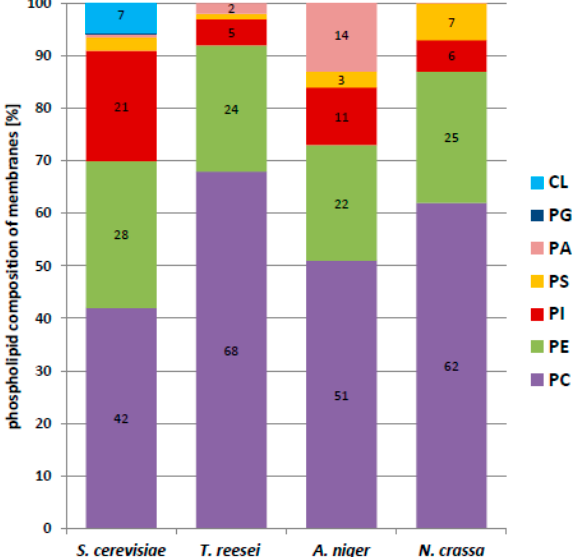
Figure 5. Phospholipid class composition of membranes from yeast and filamentous fungi. Figure